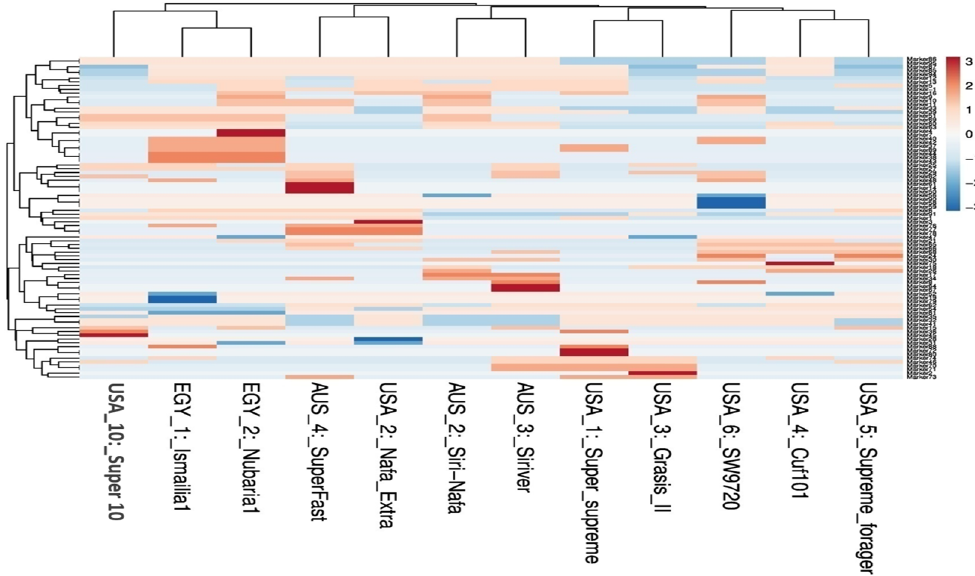
Figure 4. Multivariate heatmap illustrating the genetic diversity of 12 M. sativa cultivars based on the IRAP markers constructed using the module of heatmap of R